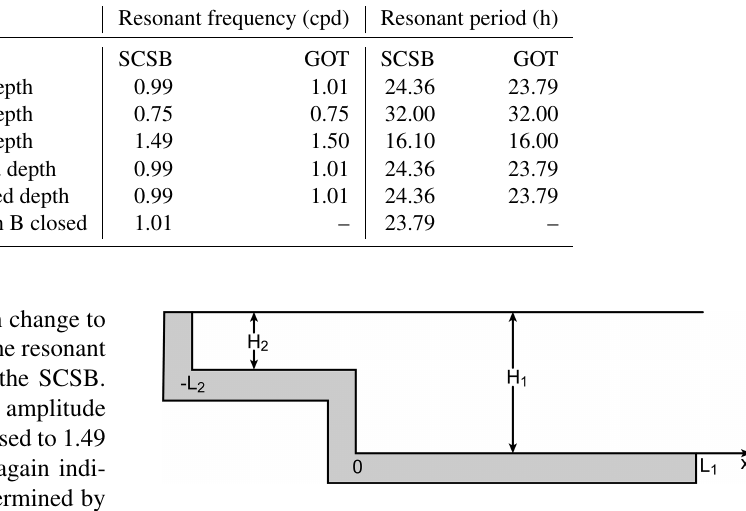
Figure 5. The two-channel model configuration representing the SCSB-GOT